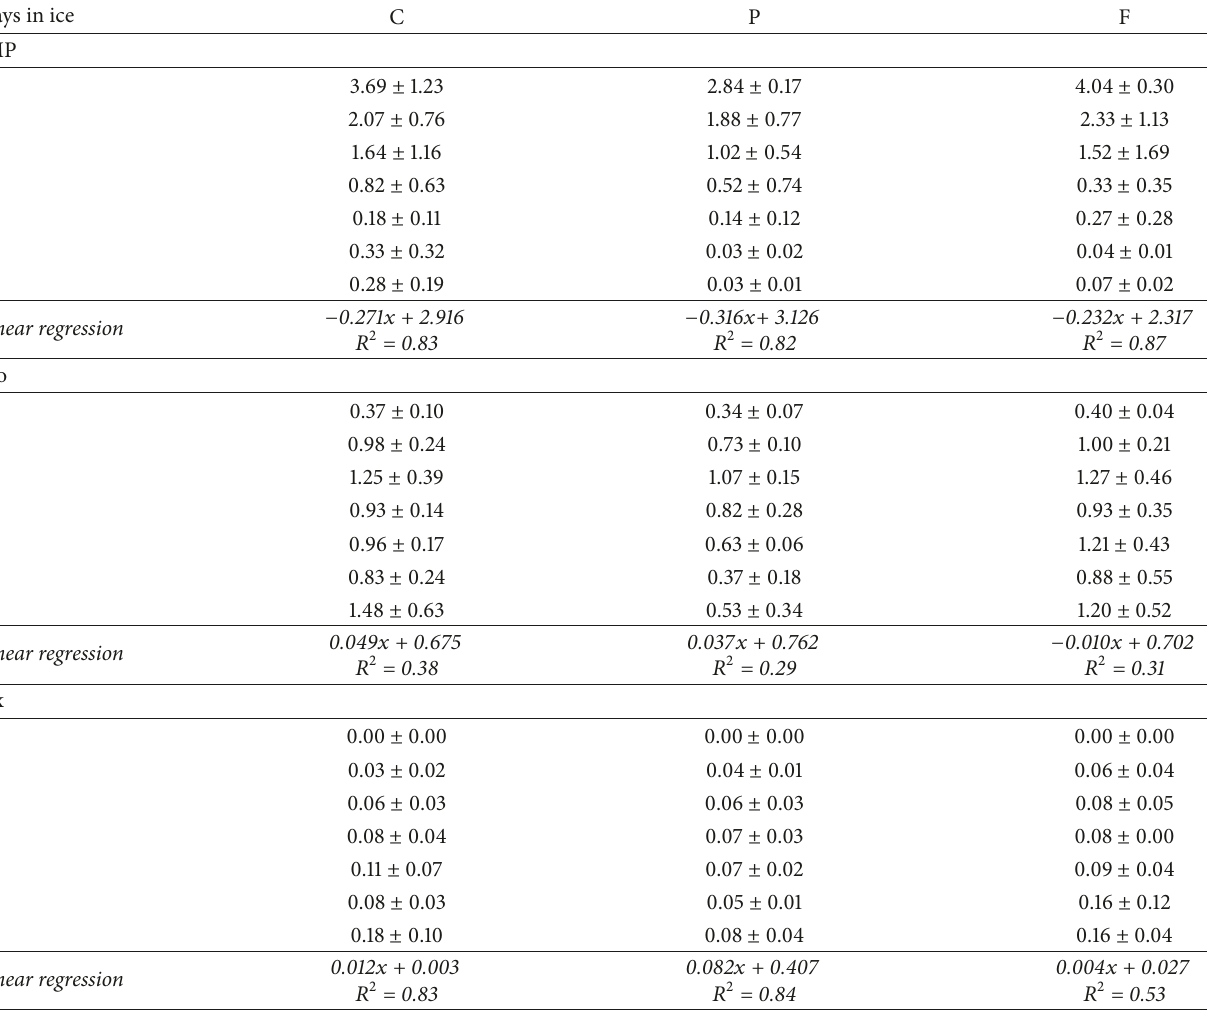
Table 8: IMP, Ino, and Hx concentrations in 𝜇 molg −1 muscle for common carp fed with the three experimental diets (C, P, and F) and stored on ice for 0–12 days postmortem. IMP: inosine monophosphate; Ino: inosine; Hx: hypoxanthine.